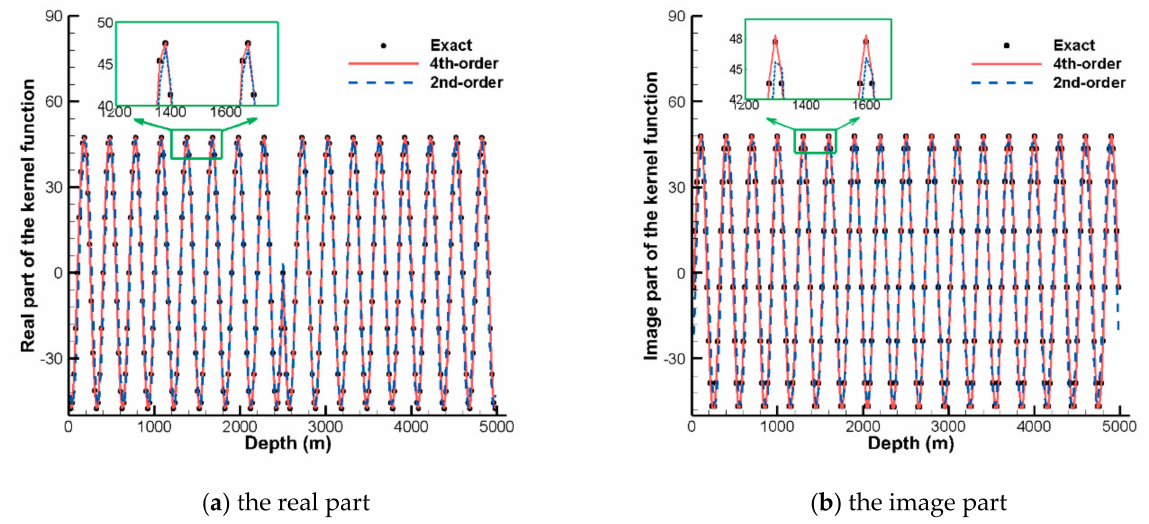
Figure 2. Comparisons of the kernel ( k r = k r ,1 , h = 20 m) obtained using the exact formula, and the 2nd- and 4th-order FD